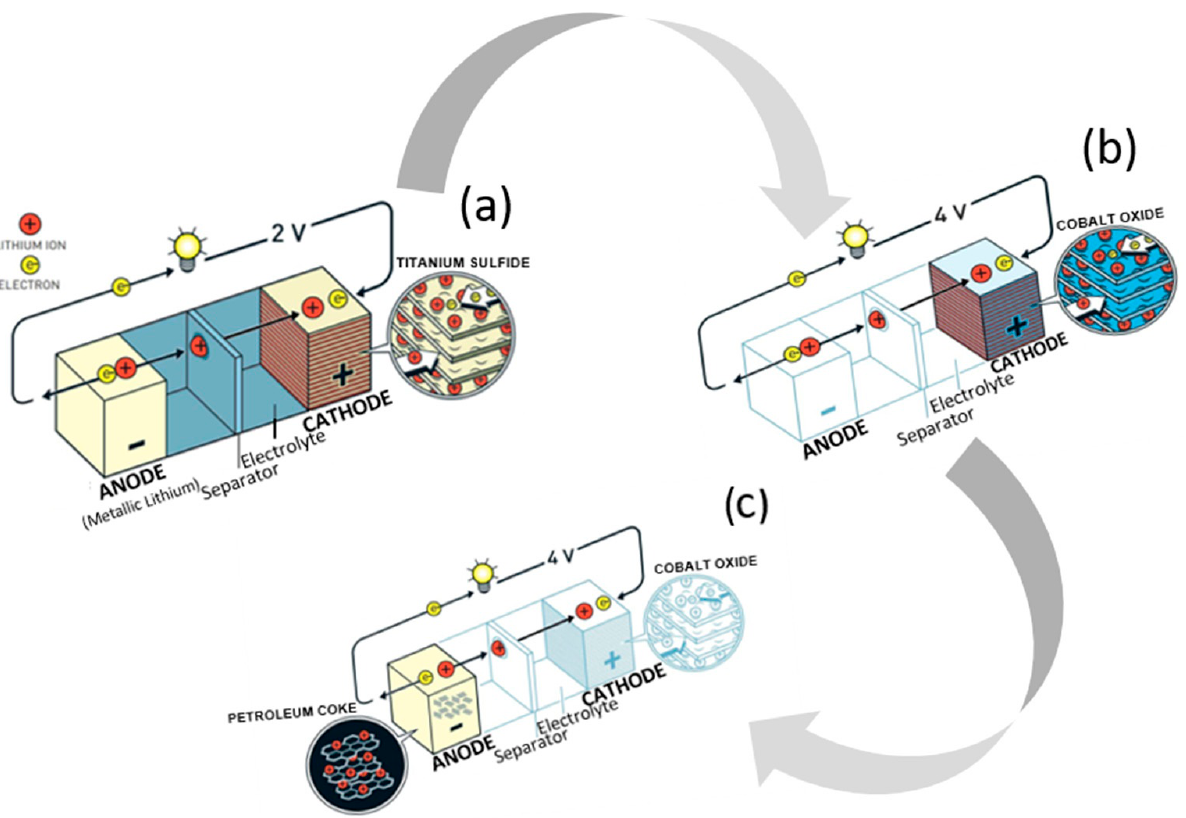
Figure 1. Battery designs by Whittingham ( a ), Goodenough (b), and Yoshino (c).